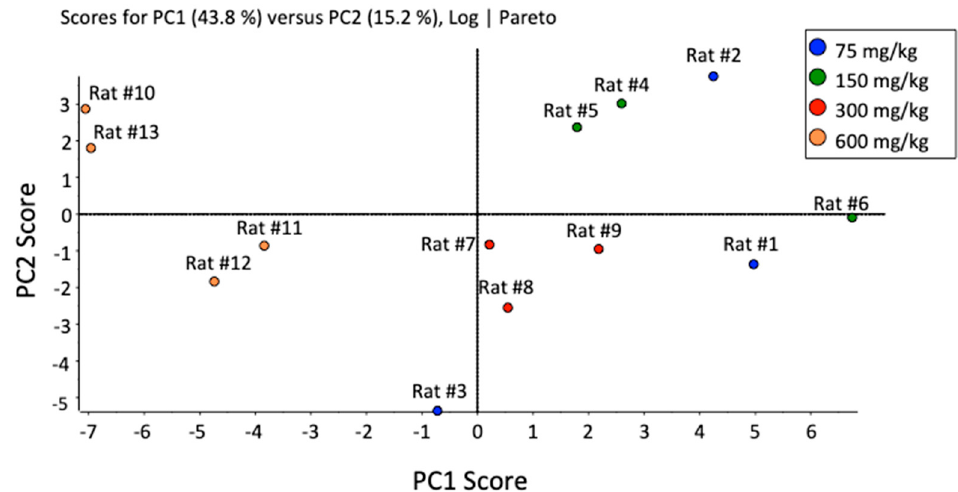
Figure 4. Unsupervised principal component analysis (PCA) of 39 bile acids detected in rat plasma samples (comparing four APAP dosing groups).